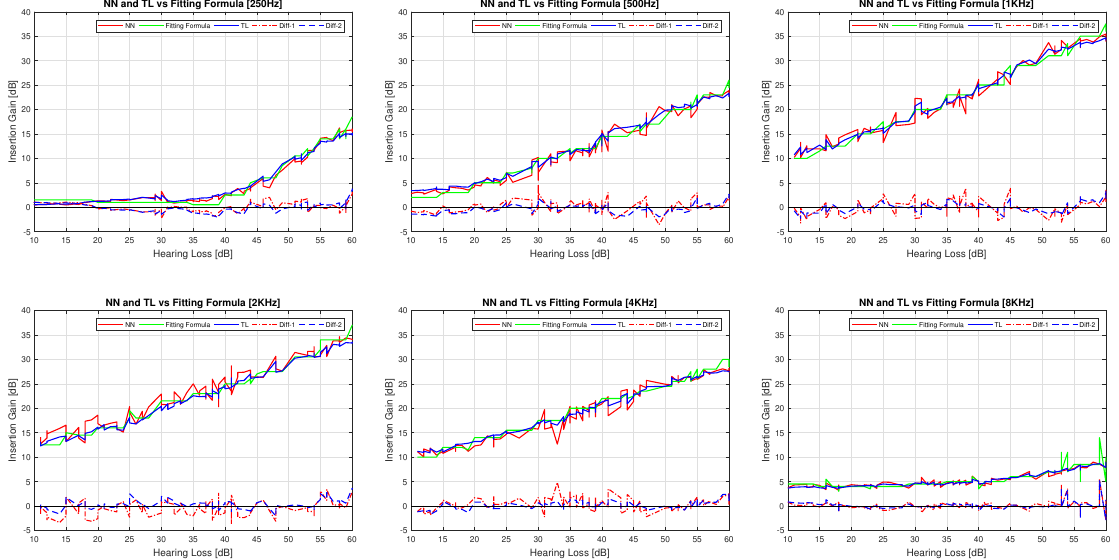
Figure 7. NAL-NL1: Performance comparison for NN and TL vs. fitting formula for the 50 dB input level. Comparisons are made for 250 Hz, 500 Hz, 1 KHz, 2 KHz, 4 KHz, and 8 KHz frequencies from top left to right to bottom left to